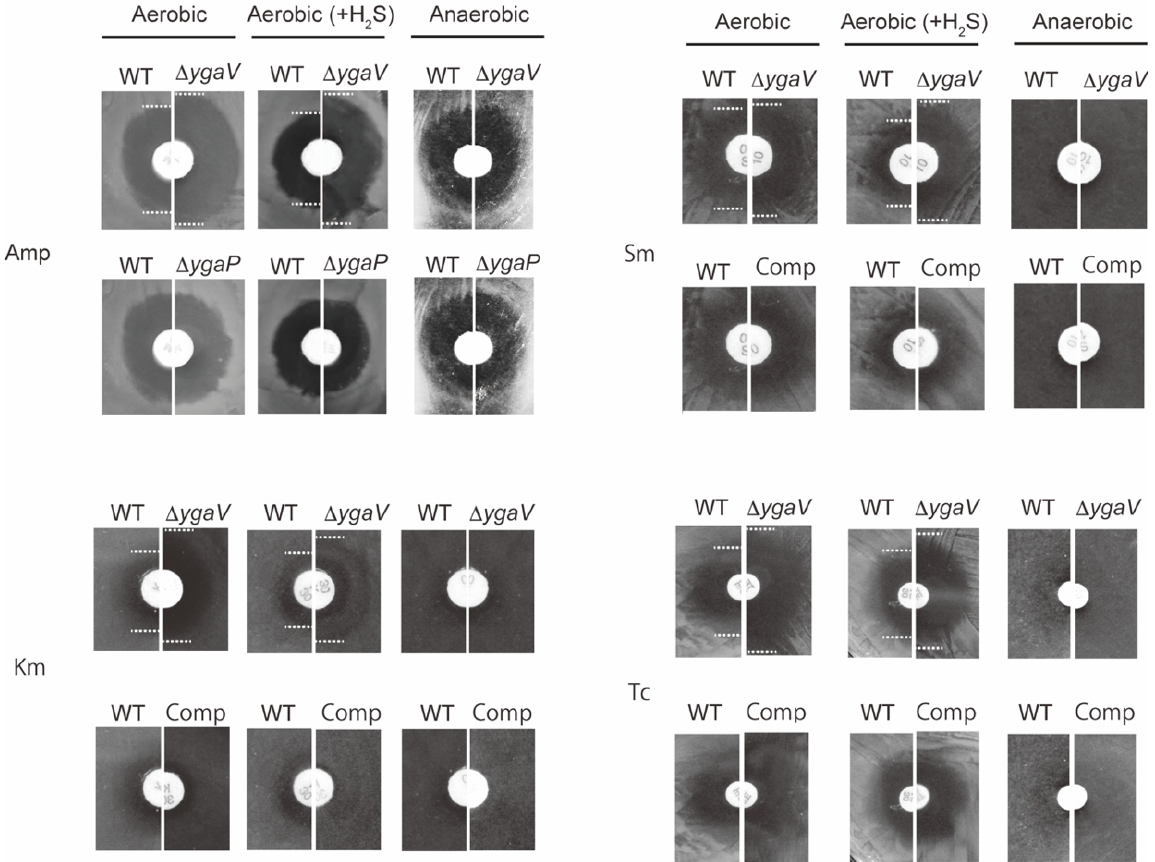
Figure 9. Phenotypic characterization of ygaV and ygaP mutants. A paper disk saturated with Amp, Km, Sm and Tc was placed on E. coli WT, ygaV complementing strain (Comp), ygaV and/or ygaP mutants’ lawns that were grown under aerobic, anaerobic, and aerobic H 2 S-atmosphere conditions for 18 h. Zone borders are marked with dotted lines to easily see the differences.